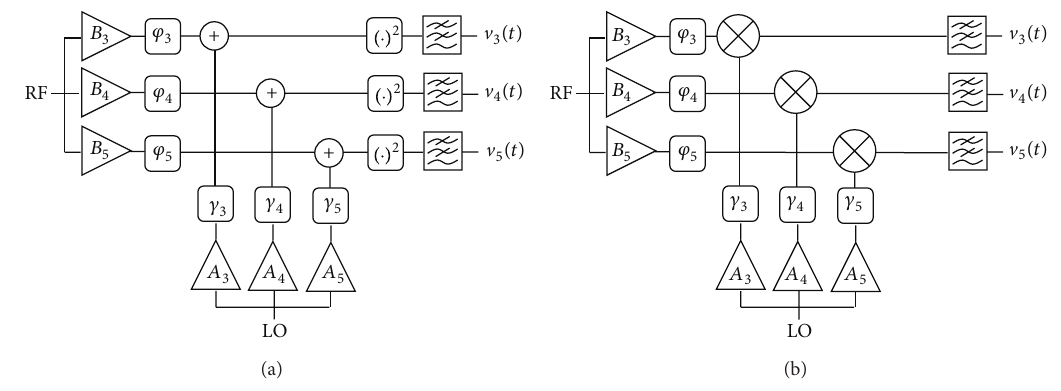
Figure 1: General model of the (a) FPD and (b)